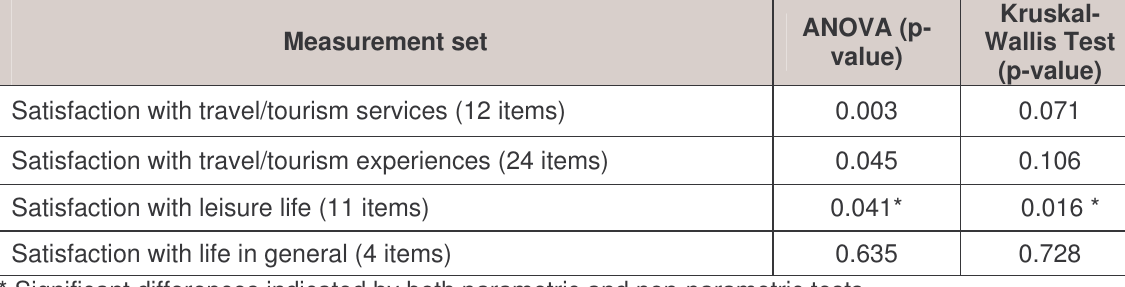
Table 9: Significance testing of the overall mean scores for satisfaction of respondents from different